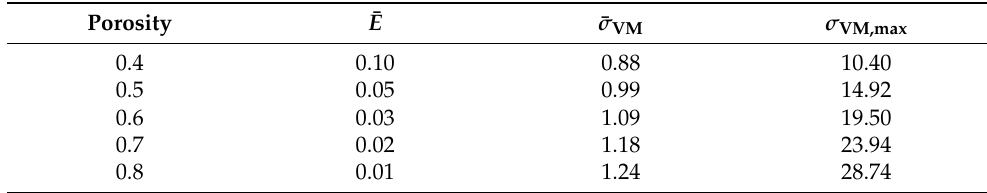
Table 4. Scaled results of the gyroid structure with a constant gradient [dimensionless] of the normalised effective Young modules ¯ E , a mean von Mises stress ¯ σ VM , and a maximum von Mises stress σ VM,max , which is given for different porosities.